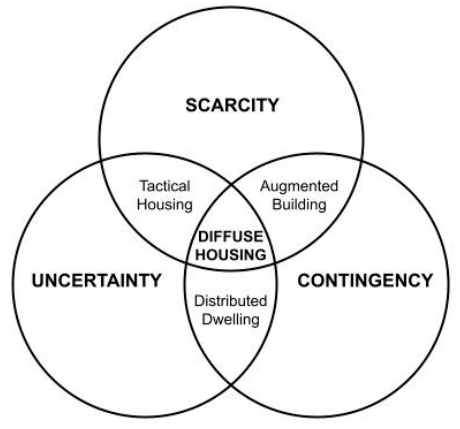
Figure 1. Theoretical framework. Author’s own construction, 2020.